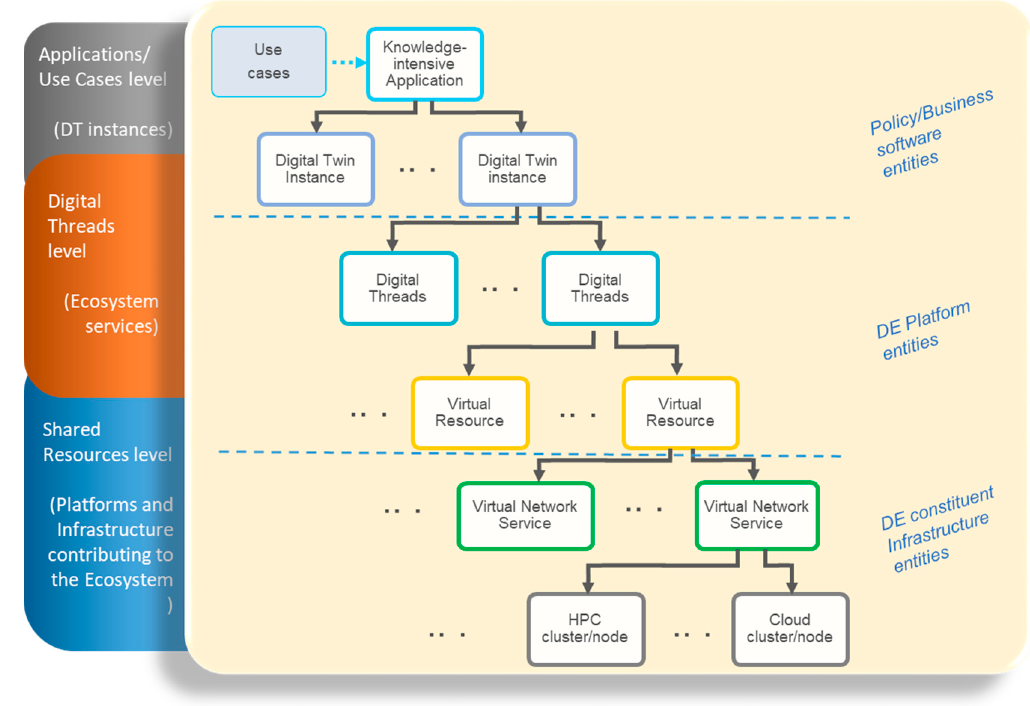
Figure 6 . Main high-level entities (and their simplified relationships) shared by a DE providing DTs of Earth.